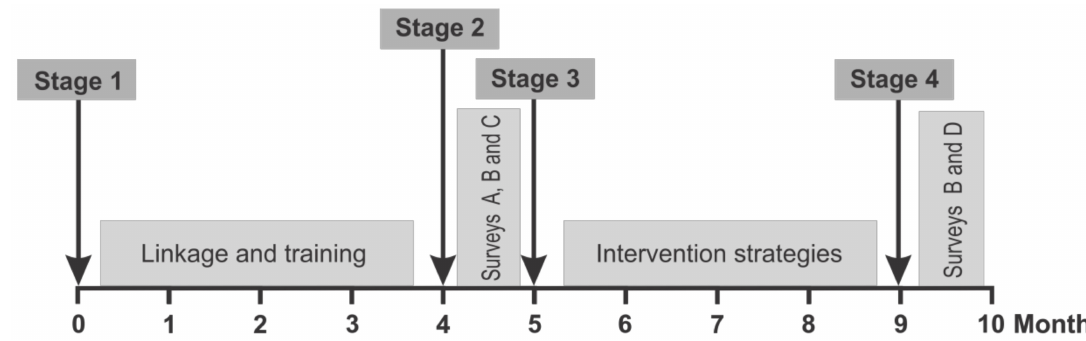
Figure 1. Educational program